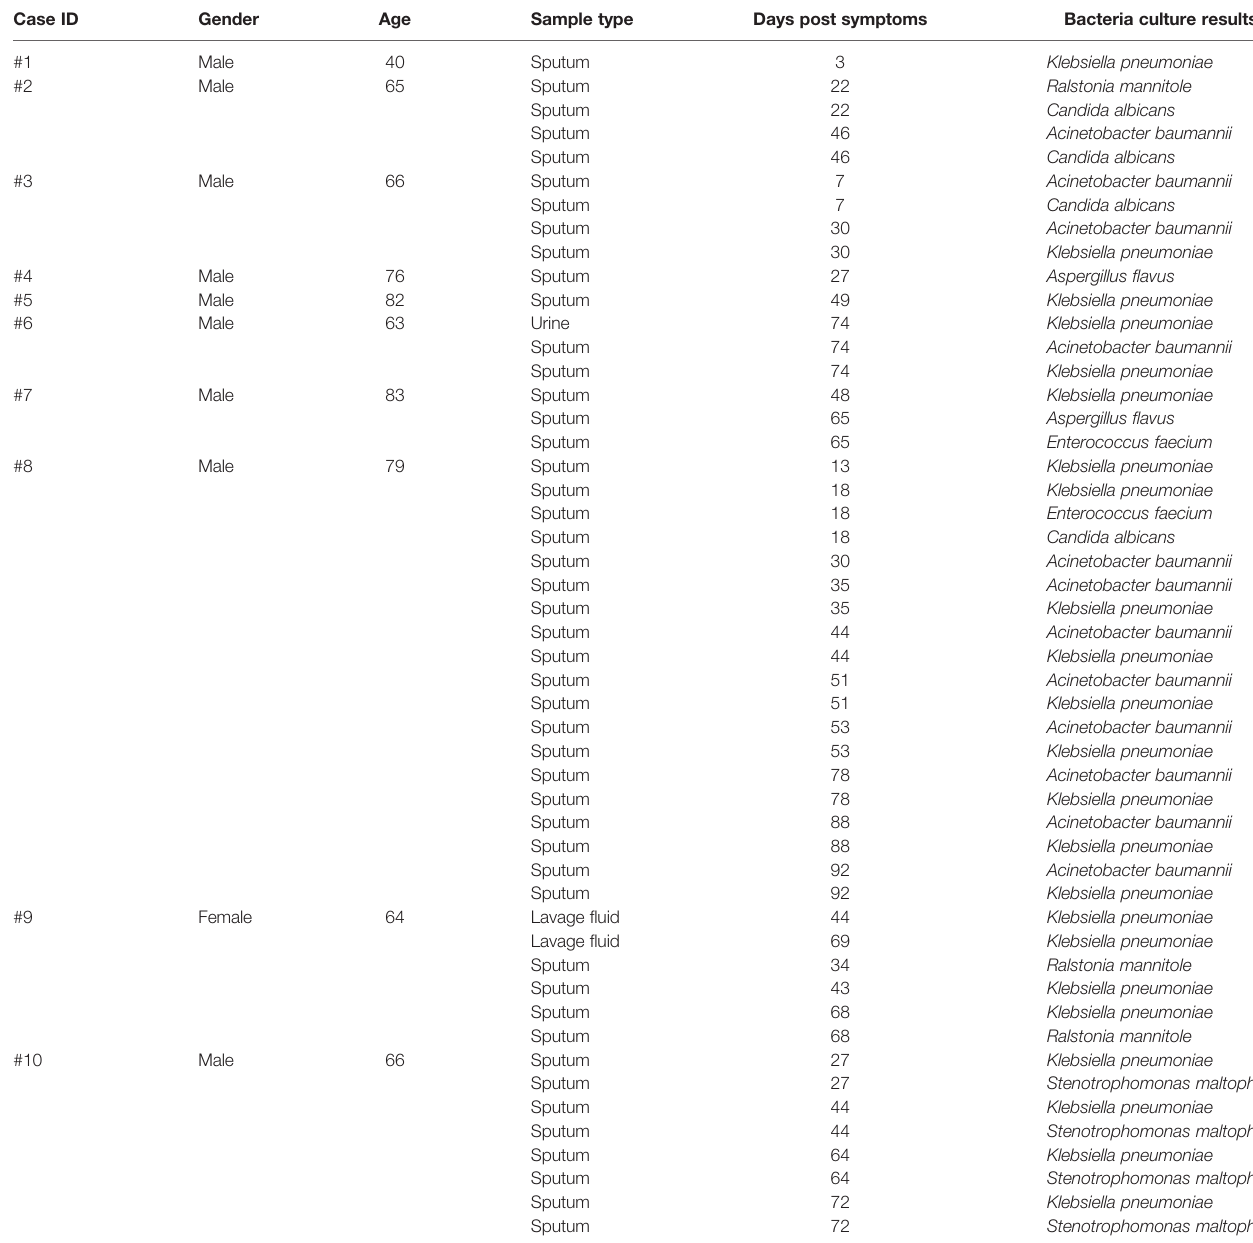
TABLE 2 | General microbiological test information of patients with secondary infection post-SARS-COV-2 infection. Case ID Gender Age Sample